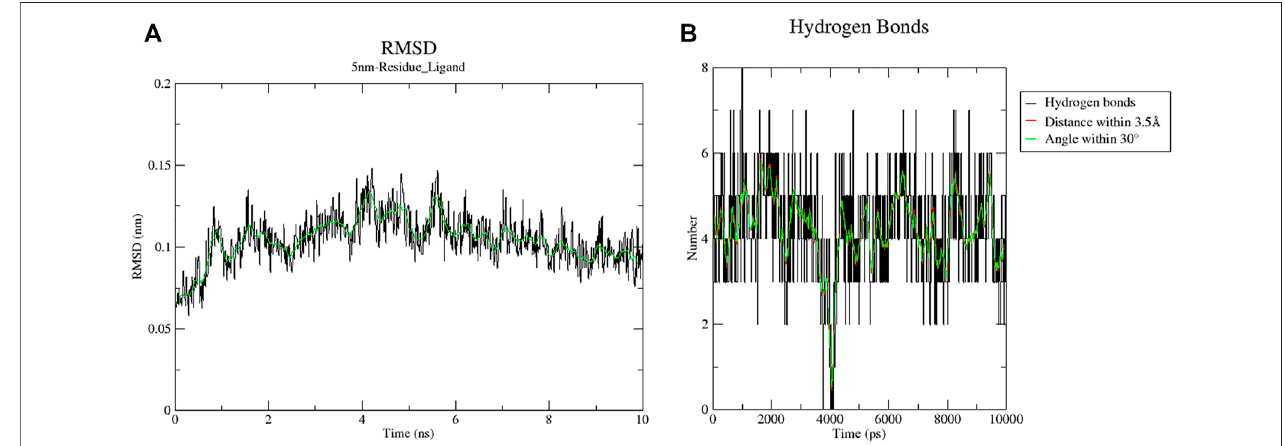
FIGURE3| Resultsof10 nssimulationof1DGFandPhloridzin.Graph (A) indicatestheRMSDvariationofproteinresidue-ligandwithin10 nswiththeligandasthe center expanding 5 nm; graph (B) indicates the change in the value of hydrogen bonding generated by this ligand with protein residues within 10 ns.